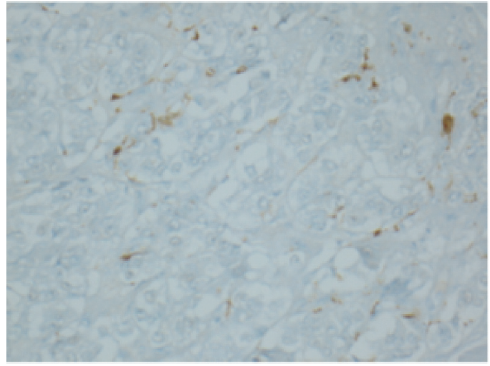
Figure 3: HC S100 sustentacular cells.